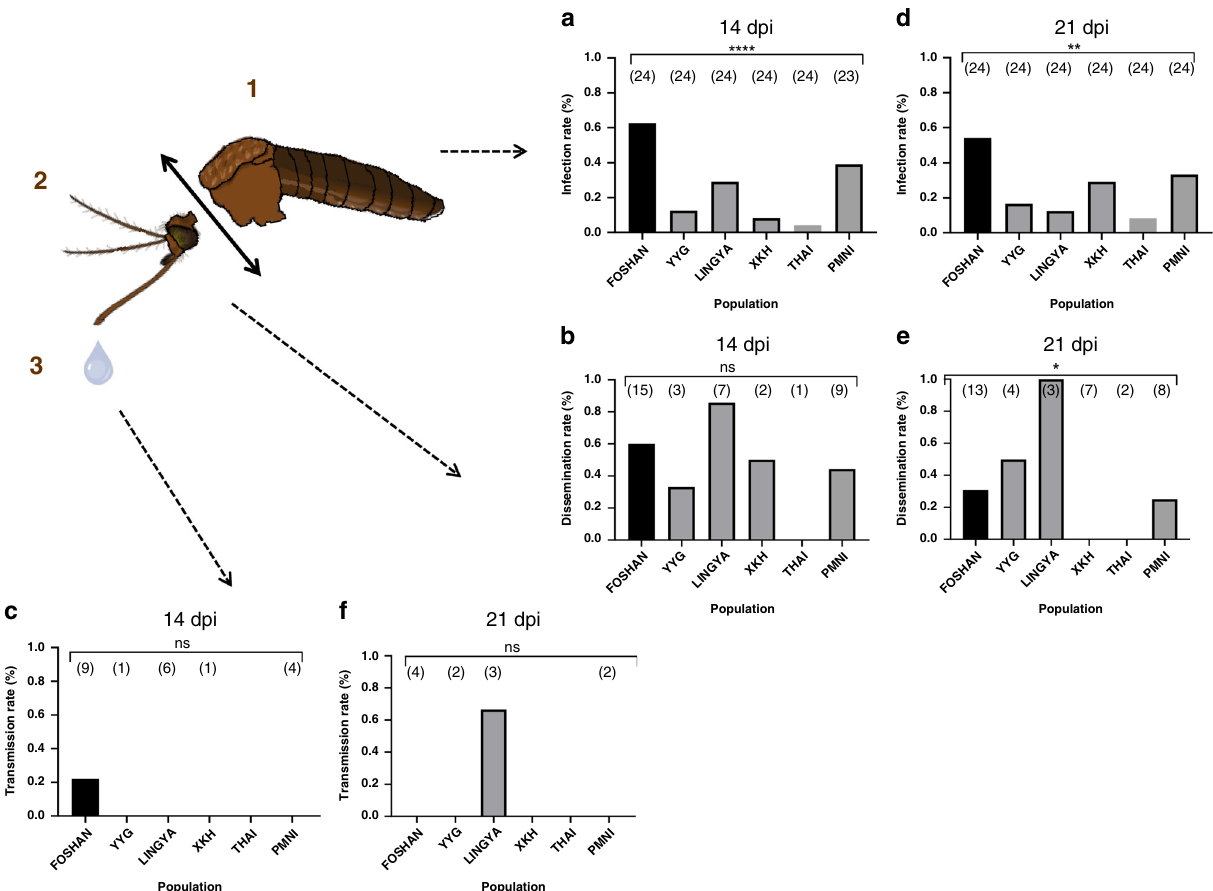
Fig. 2 Vector competence of 6 Aedes albopictus populations assessed 14 and 21 days after an infectious blood meal containing 10 7 ffu/mL of YFV (West-African genotype). Batches of mosquitoes were examined in each population for viral infection ( a , d ), dissemination ( b , e ), and transmission ( c , f ) by estimating respectively the proportion of mosquitoes with infected bodies (1), head (2), and saliva (3). Infection rate (IR) refers to the percentage of mosquitoes having an infected body among blood-fed mosquitoes. Dissemination rate (DR) is the percentage of mosquitoes with an infected head (containing viral particles having disseminated in the general cavity after crossing successfully the midgut) among mosquitoes with an infected body. Transmission rate (TR) corresponds to the percentage of mosquitoes with infectious saliva (viral particles having successively crossed the two anatomical barriers, midgut and salivary glands) among mosquitoes with infected head. Stars indicate statistical signi fi cance of comparisons by Fisher ’ s exact test (two-sided test; * P ≤ 0.05, ** P ≤ 0.01, **** P ≤ 0.0001 ) . a **** P ≤ 0.0001; d ** P = 0.003; e * P = 0.038. ns (non-signi fi cant) indicates a lack of statistical signi fi cance ( P > 0.05). In brackets are the numbers of mosquitoes tested. dpi days post-infection. Source data are provided in Supplementary Data 1 fi for mosquitoes capable of viral transmission (Supplementary When analyzing viral loads in body and saliva, no signi fi cant Fig. 3). Viral loads in the body (Fig. 4a) and saliva (Fig. 4c) were difference was found between mosquitoes from Africa, Asia, and not signi fi cantly different (Kruskal – Wallis: P > 0.05), while viral the Paci fi c region (Table 1, respectively, P = 0.11 and P = 0.54). loads in the head were signi fi cantly higher (Fig. 4b) in mosquitoes Taken altogether, these results indicate that compared to from Africa (10 4.6±3.7 ) compared to Asia (10 3.9±3.9 ) and Paci fi c mosquitoes from Africa, Ae. aegypti mosquitoes from the Asia- (10 3.7±3.6 ) regions (Kruskal – Wallis test: P > 0.05). Paci fi c region hosted signi fi cantly lower viral particles in the head Viral loads in the body were signi fi cantly correlated with viral but presented similar viral loads in body and saliva, suggesting loads in the head ( ρ = 0.31, P = 0.012) (Supplementary Fig. 4a). that only viral dissemination distinguishes Ae. aegypti mosquitoes However, no correlation was detected between viral loads in body from the three continents. and saliva ( ρ = 0.22, P = 0.11; Supplementary Fig. 4b), or between virals loads in head and saliva ( ρ = 0.04, P = 0.77; Supplementary Ability of different Aedes aegypti populations to transmit YFV . Fig. 4c). To investigate the difference in terms of viral loads in To determine the risk of mosquito-mediated YFV transmission at body, head, and saliva between mosquitoes from different each location, we used transmission ef fi ciencies (Supplementary geographic origins, we used a linear regression model. To identify Fig. 1) and probabilities of vector occurrence (data from Kraemer the main factor conditioning the correlation between viral loads et al. 28 ). When considering only Ae. aegypti from Asia, regions in body, head, and saliva, we used a logistic regression model. where CSP (Thailand), TRUNG (Vietnam) and NANZI (Taiwan) The analysis corroborated that compared to mosquitoes from populations are located, presented a higher transmission risk of Africa used as the reference, Ae. aegypti from Asia presented YFV (CSP: 54% [32.8 – 74.4%], TRUNG: 25% [9.8 – 48.7%], a lower viral load in the head (the level is − 0.73 log lower in NANZI: 21% [7.1 – 42.2%]). In these regions, mosquito occurrence mean in Asian than in African mosquitoes) as for mosquitoes is predicted to be high and overall constant within a 5 km radius, from the Paci fi c region ( − 0.82 in mean) (Table 1, P = 0.01). allowing for competent vectors to place immunological naive